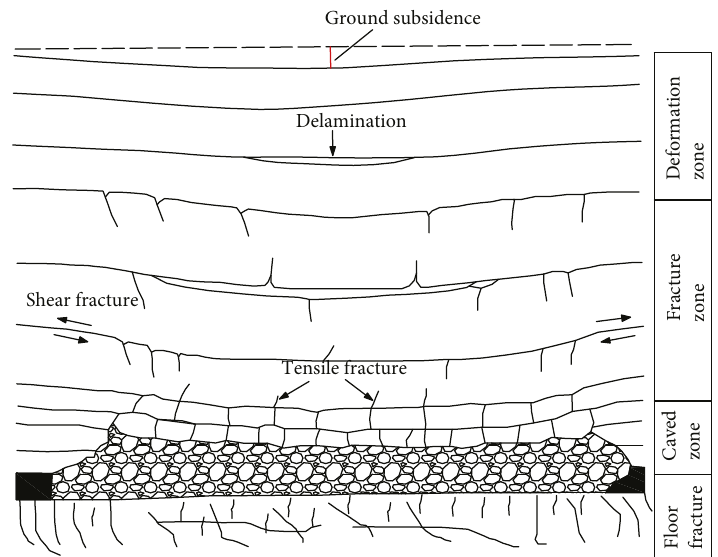
Figure 1: The global pro fi le of longwall mining-induced fractures (modi fi ed from